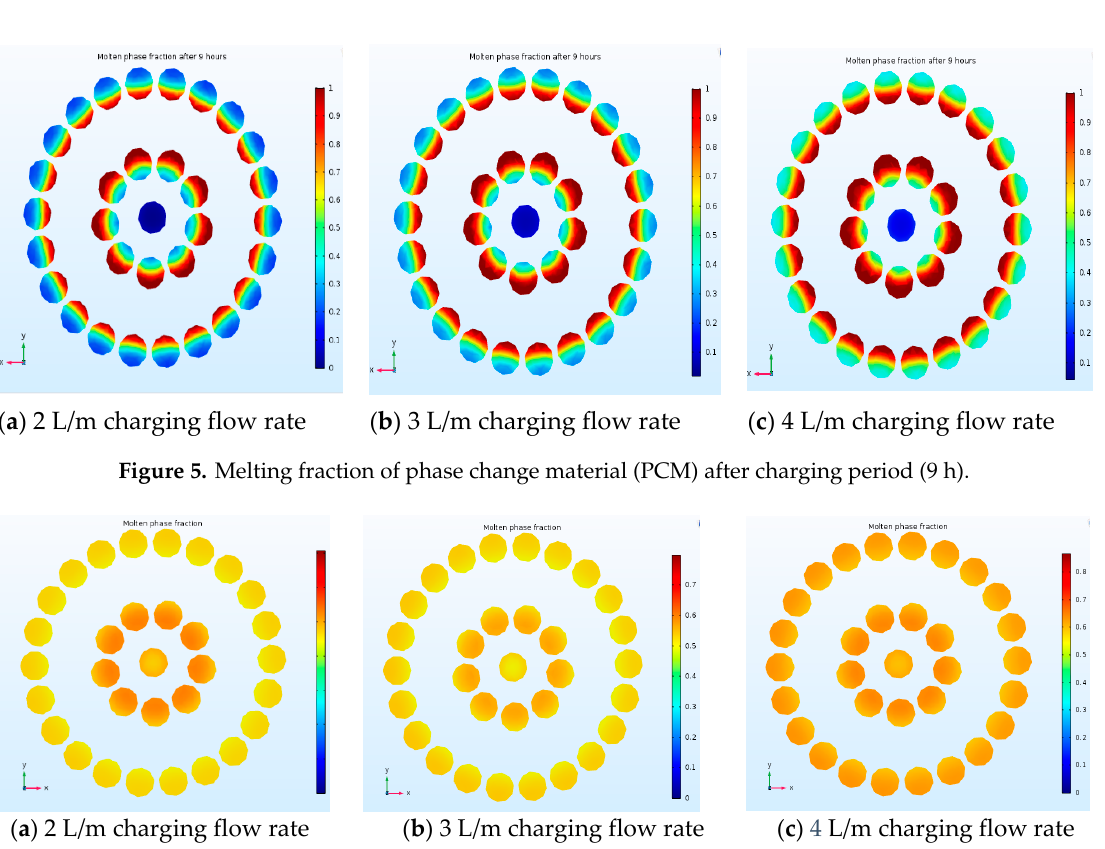
Figure 6. Melting fraction of phase change material after discharge period (24 h).